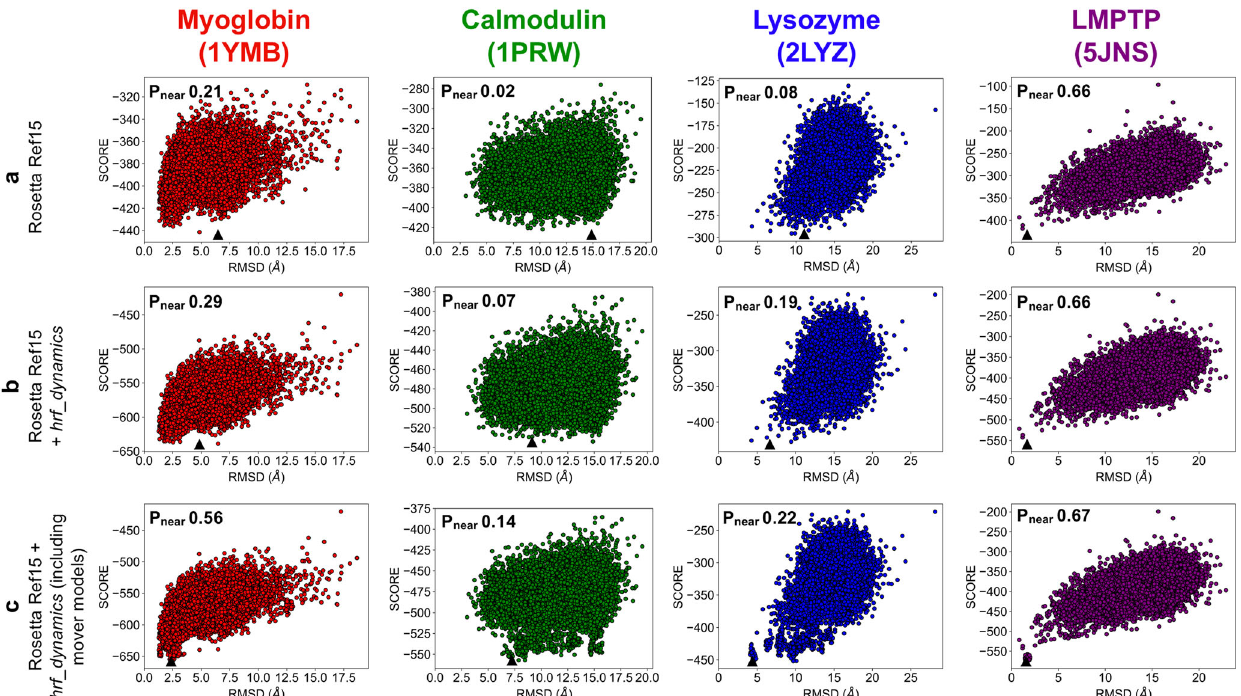
Fig. 2 Score versus RMSD to the crystal structure for 20,000 ab initio models generated for each of the four benchmark proteins with the top-scoring model marked by a black triangle. The P near value is denoted on each plot. Myoglobin models are shown in red, calmodulin in green, lysozyme in blue, and LMPTP in purple. a Rosetta Ref15 score versus RMSD. b Rosetta Ref15 + hrf_dynamics total score versus RMSD. c Rosetta Ref15 + hrf_dynamics total score versus RMSD, including the 30 mover models generated per structure for the top 20 scoring